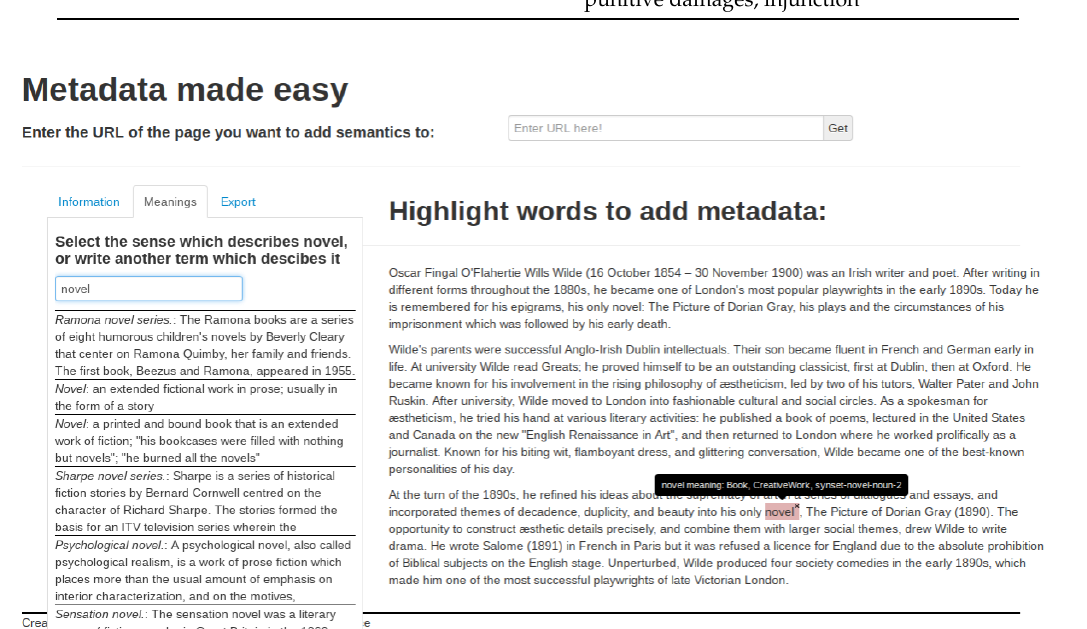
Figure 4. The highlighted word is disambiguated by the panel on the left. The WordNet synset is mapped to the closest schema.org type and SUMO concept, and the metadata are added to the HTML source